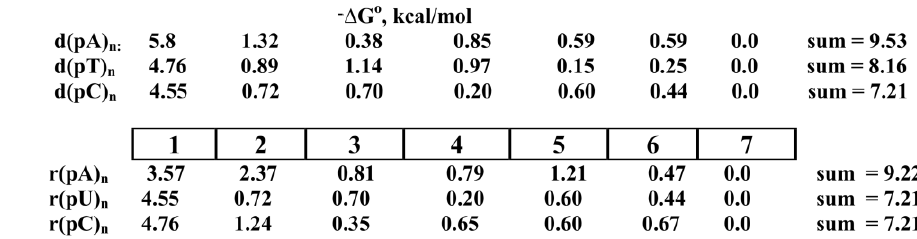
Figure 19. Thermodynamic model ( − ∆ G ◦ values) characterizing a relative contribution of different mononucleotides of ss d(pN) 7 and ribo(pN) 7 to the total affinity of these (pN) 7 for human milk α-lactalbumin (LA) [126]. Different ss (pN) 7 are shown on the Panel.